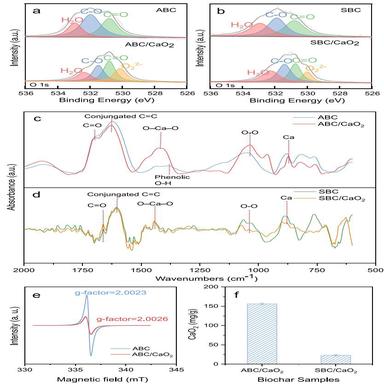
Surface chemical changes before and after modification. a) XPS O1s spectra of ABC and ABC/CaO2. b) XPS O1s spectra of SBC and SBC/CaO2. c) FT-MIR spectra of the ABC and ABC/CaO2. d) FT-MIR spectra of the SBC and SBC/CaO2. e) The EPR spectra of ABC and SBC/CaO2. f) Coating efficiency of CaO2 on ABC/CaO2 and SBC/CaO2.